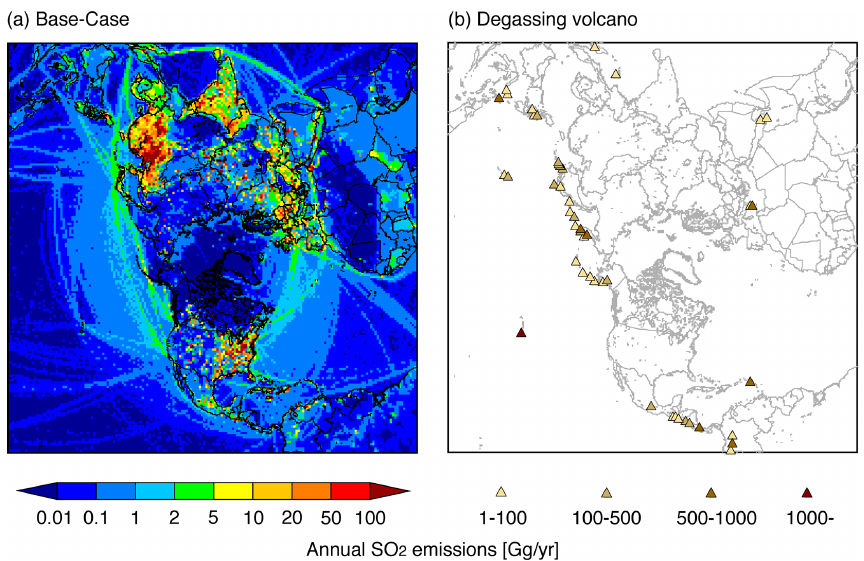
Figure 1. Geographical mapping of the (a) original SO 2 emissions used in H-CMAQ and (b) degassing volcanic annual SO 2 emissions incorporated in this study during 2010.